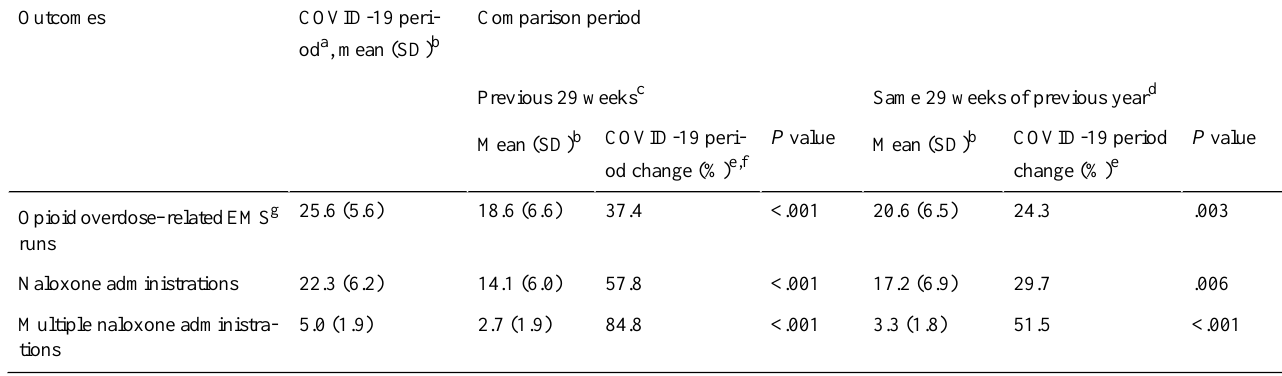
Table 1. Mean and percent change in EMS runs involving opioid overdoses, naloxone administrations, and multiple naloxone administrations in Guilford County, North Carolina before and after the COVID-19 state of emergency declaration.